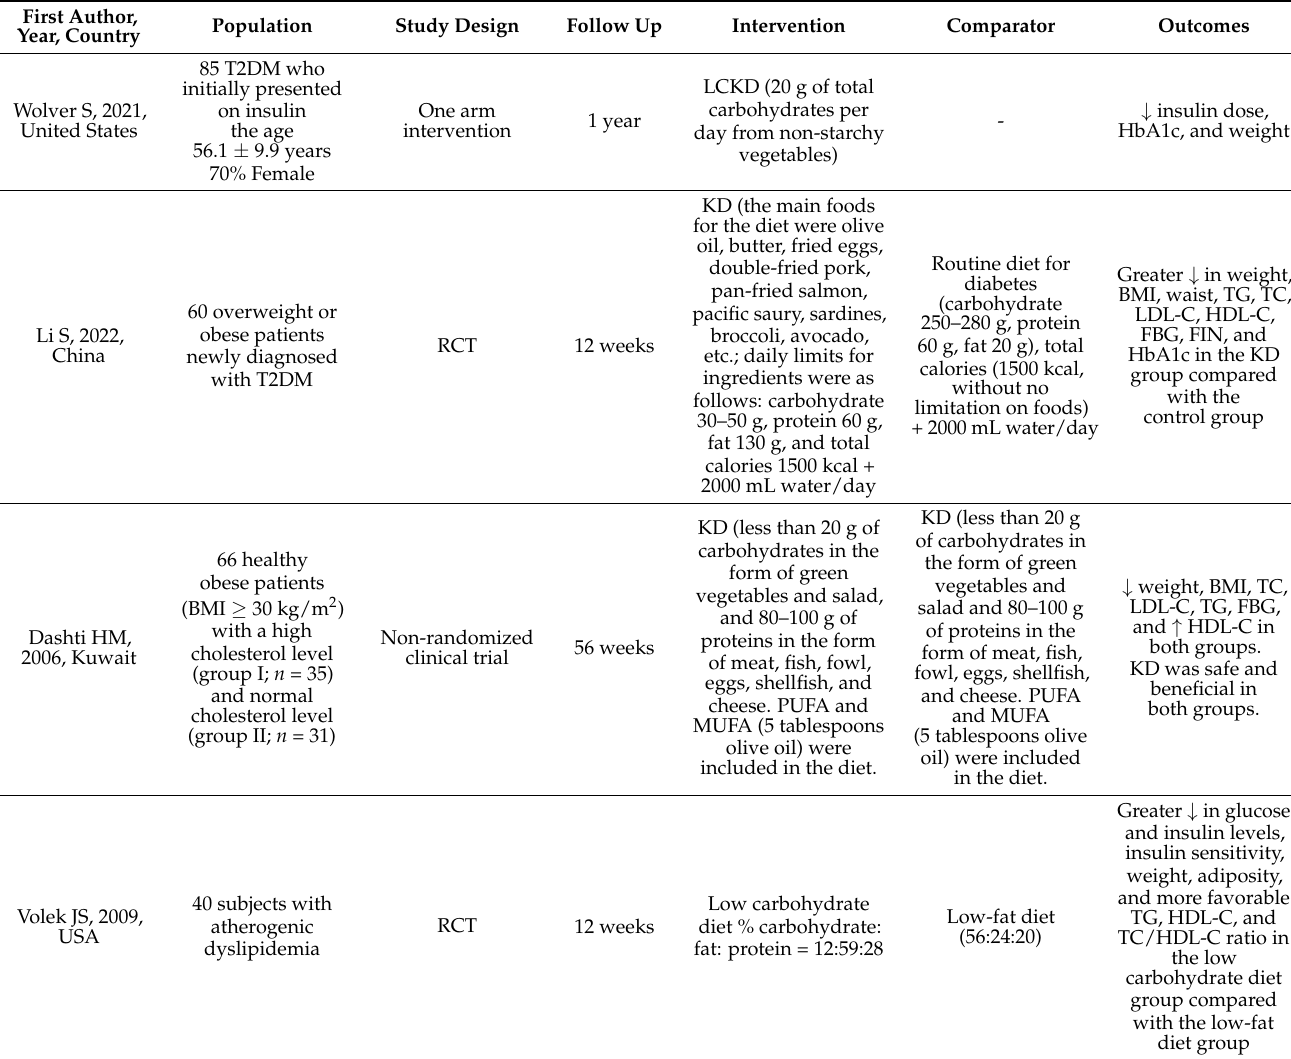
Table 2. Summary of studies that assessed shared mechanisms between cancer and cardiovascular diseases